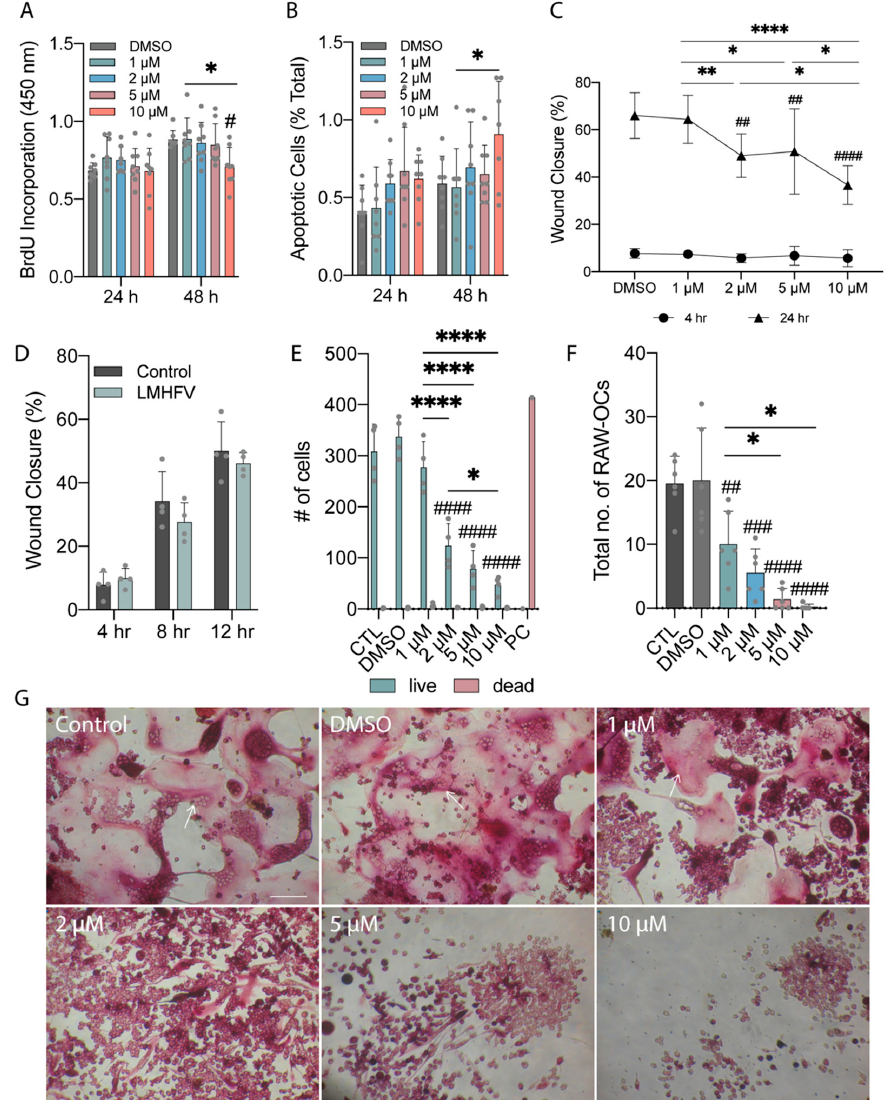
Figure 3. Yoda1 treatments suppressed proliferation and migration of breast cancer cells and reduced osteoclastogenesis. ( A ) Cell proliferation of MDA-MB-231 and ( B ) percentage of apoptotic MDA-MB-231 after subjected to DMSO or 1, 2, 5, 10 μ M Yoda1 for 24 and 48 h ( n = 8). ( C ) Migration of MDA-MB-231 after subjected to DMSO or 1, 2, 5, 10 μ M Yoda1 for 4 and 24 h ( n = 8). ( D ) Migration of MDA-MB-231 at 4, 8, and 12 h after subjected to vibration of 0.3 g, 60 Hz for 1 h ( n = 4). ( E ) Live-dead measurements of RAW264.7 under medium (Control), DMSO, or dose-dependent Yoda1 for 48 h ( n = 4 for DMSO and Yoda1 treatments, n = 1 for PC). PC: positive control. ( F ) Total number of TRAP-positive RAW-OCs with more than 2 nuclei after 7-day incubation in medium (Control), DMSO, or dose-dependent Yoda1 supplemented with 20 ng/mL RANKL ( n = 6). ( G ) Representative images of multinucleated RAW-OCs for the groups described in ( F ). Arrows indicate the representative TRAP-positive RAW-OCs. Scale bar = 100 μ m. **** p < 0.0001, ** p < 0.01, * p < 0.05; #### p < 0.0001, ### p < 0.001, ## p < 0.01, # p < 0.05 in comparison to DMSO control.